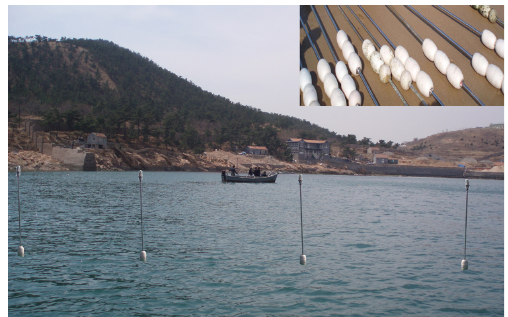
Figure 4. Experiments for the ocean monitoring.